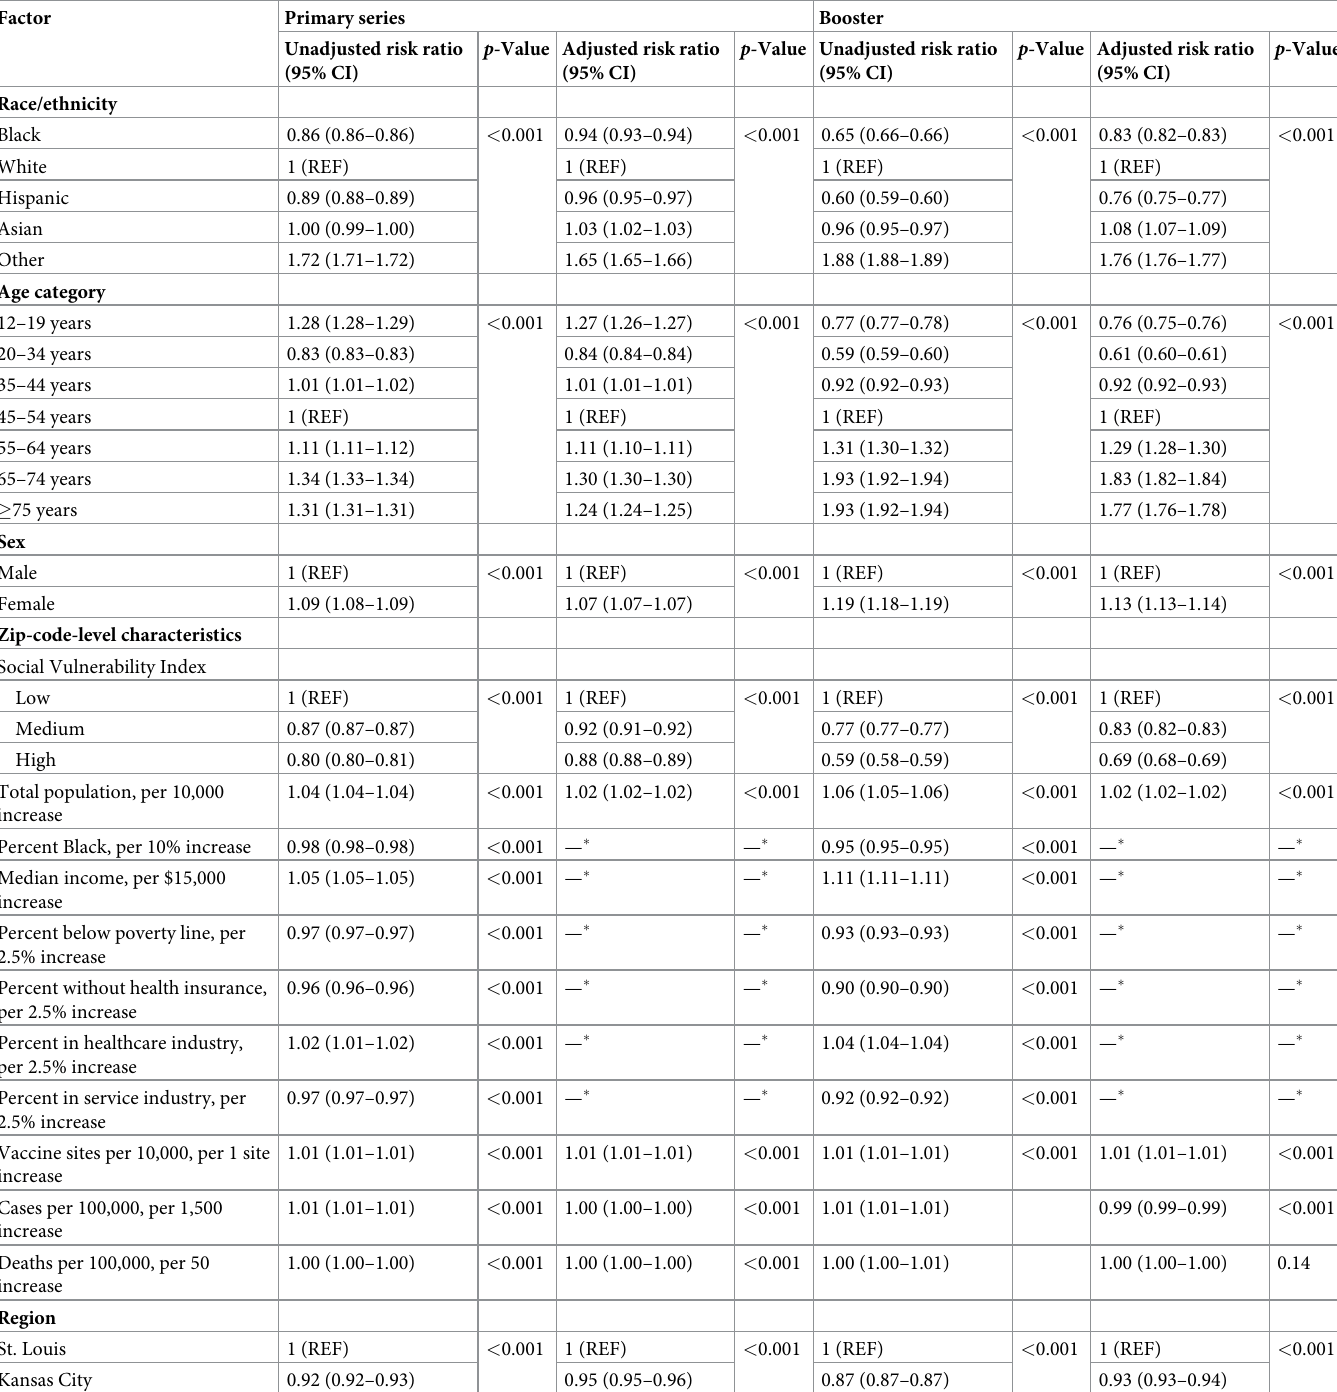
Table 3. Poisson model of individual- and zip code-level factors associated with receipt of primary COVID-19 vaccination series and